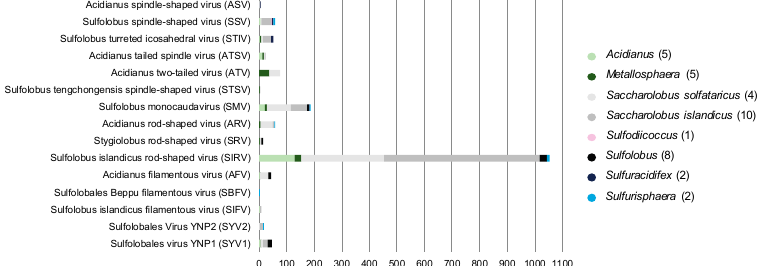
Figure 5. CRISPR array, spacers and virus matches in Sulfolobales genera. ( A ) The number of arrays (depicted in di ff erent color shadings) and the number of spacers per array are shown for representative genomes of the Sulfolobales. ( B ) The stacked bar plot shows the total amount of spacers identified on the genus level that (partially) match protospacers carried on genomes of viruses associated with the Sulfolobales. The data (CRISPR arrays and spacer) for the analyses were retrieved using programs CRISPRCasFinder (CRISPR-Cas++ 1.1.2, [241]) and orientation of CRISPR arrays was determined using CRISPRstrand (implemented in CRISPRmap v1.3.0-2013, [265,266]). Virus matches were identified using BLAST+ (version 2.10.0, [267]), spacers were blasted against the NCBI viral genomic RefSeq database [268] specifying the following parameters: word size = 8, e-value ≤ 0.01. Results were filtered for a query coverage ≥ 85% (calculated by dividing the alignment length by the query length) and allowing for a maximum number of 5 mismatches (see Supplementary Table S1), duplicate hits of a spacer to the same virus were